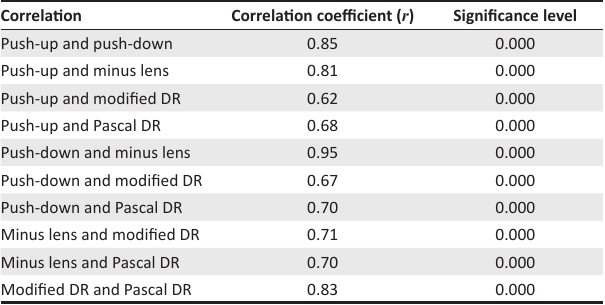
TABLE 3: Direct comparison between the individual procedures for the amplitude of accommodation. Correlation